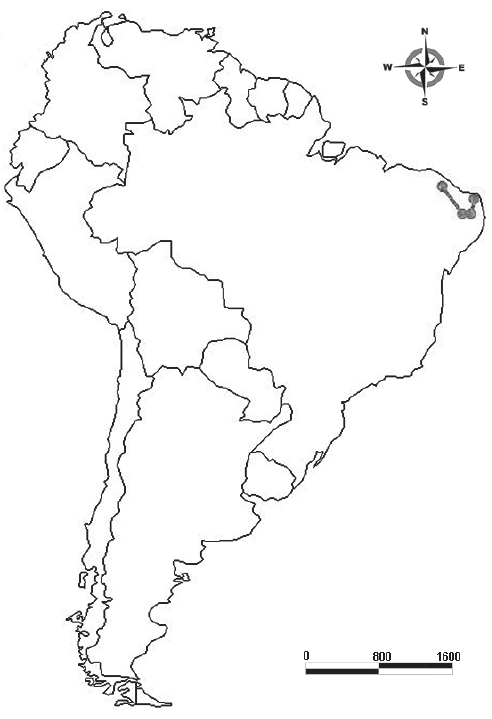
Fig. 20 - Individual track of Parapanochthus jaguaribensis .